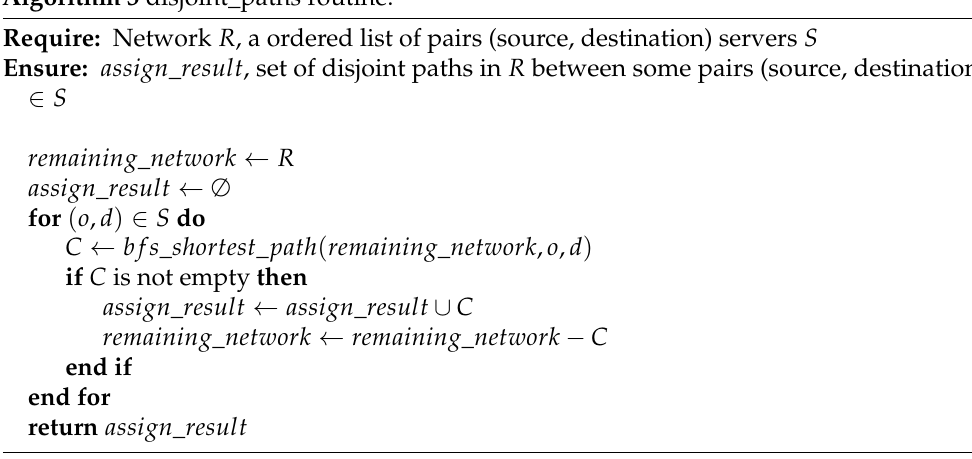
Algorithm 3 disjoint_paths